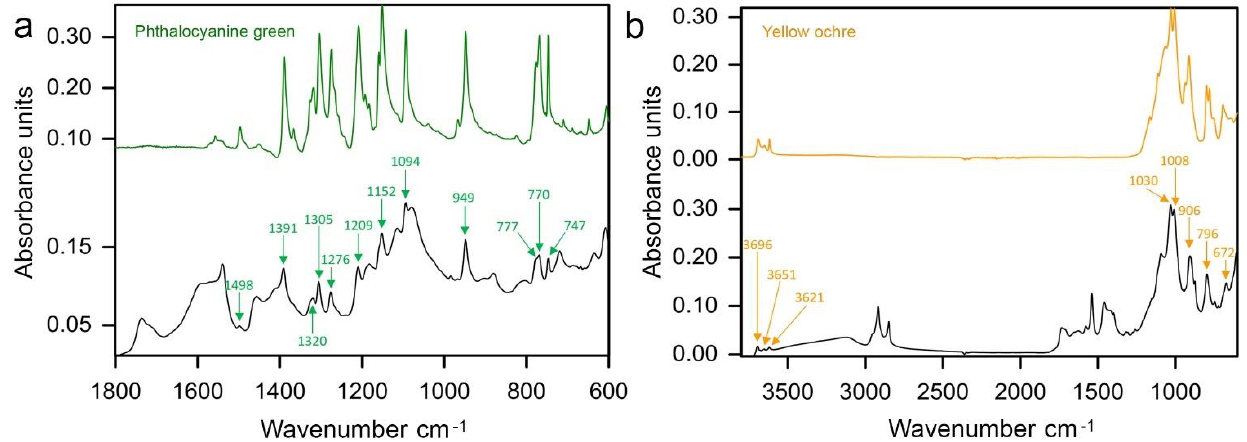
Figure 13. ( a ) ATR – FTIR spectra of the green paint of sample 4 extracted from Mount Huangshan (1983), with labelled marker peaks of phthalocyanine green and reference spectra of the same pigment. ( b ) ATR – FTIR spectra of the green paint of sample 4 extracted from Mount Huangshan (1986), with labelled marker peaks of yellow ochre admixture and reference spectra of the same pigment.